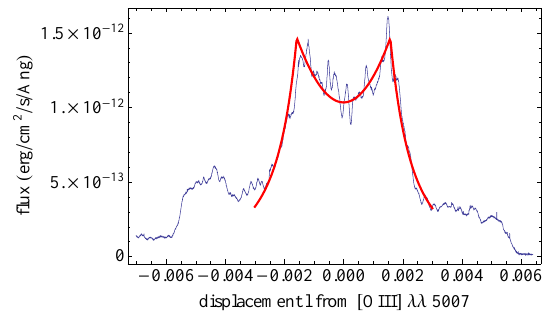
Figure 1: The saddle-shaped profile in the [OIII] 5007 line and the best fit (red line) obtained with the method described in the text.